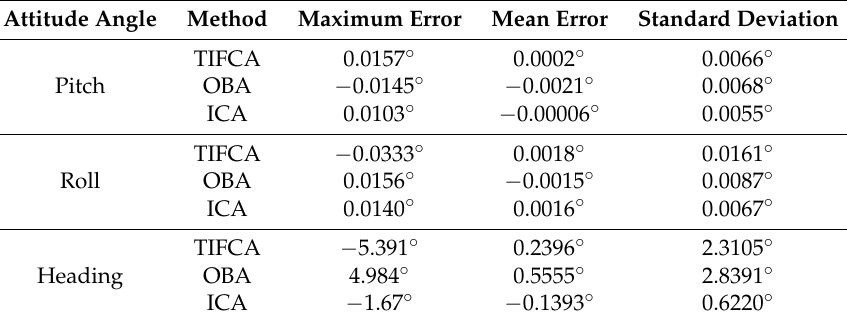
Figure 4. The attitude angle errors of 50 coarse alignments. The abscissa denotes the order N of the alignments, and the ordinate denotes the errors of the pitch angle, roll angle and heading angle, respectively. Table 2. The simulation result of 50 coarse